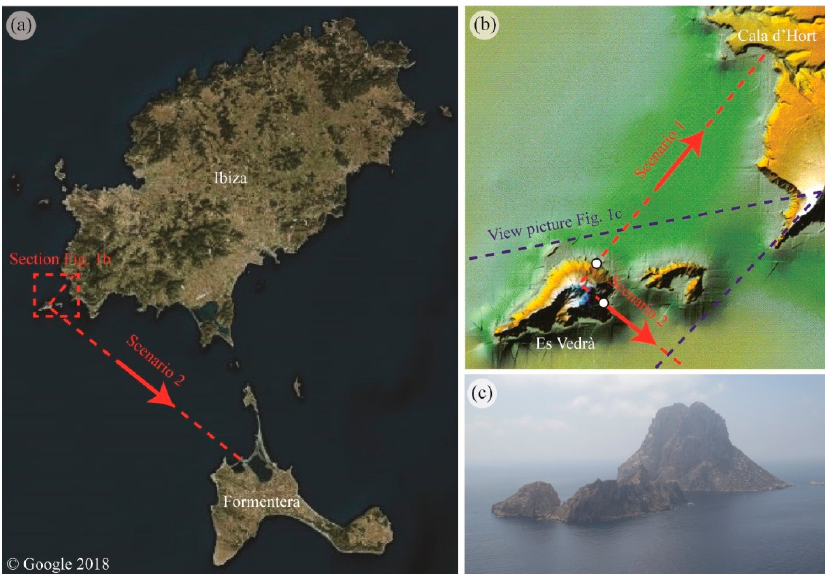
Figure 1. ( a ) Plan view of Ibiza and Formentera with Es Vedrà and tsunami propagation towards Cala d’Hort (scenario 1) and Marina de Formentera (scenario 2) marked with red dashed lines (adapted from Google maps); the red dashed square highlights the region shown in ( b ). ( b ) Reproduced bathymetry [36] and topography [37] in proximity of Es Vedrà with the range covered by the picture in ( c ) marked with blue dashed lines. ( c ) Picture of Es Vedrà taken by V. Heller from Ibiza.